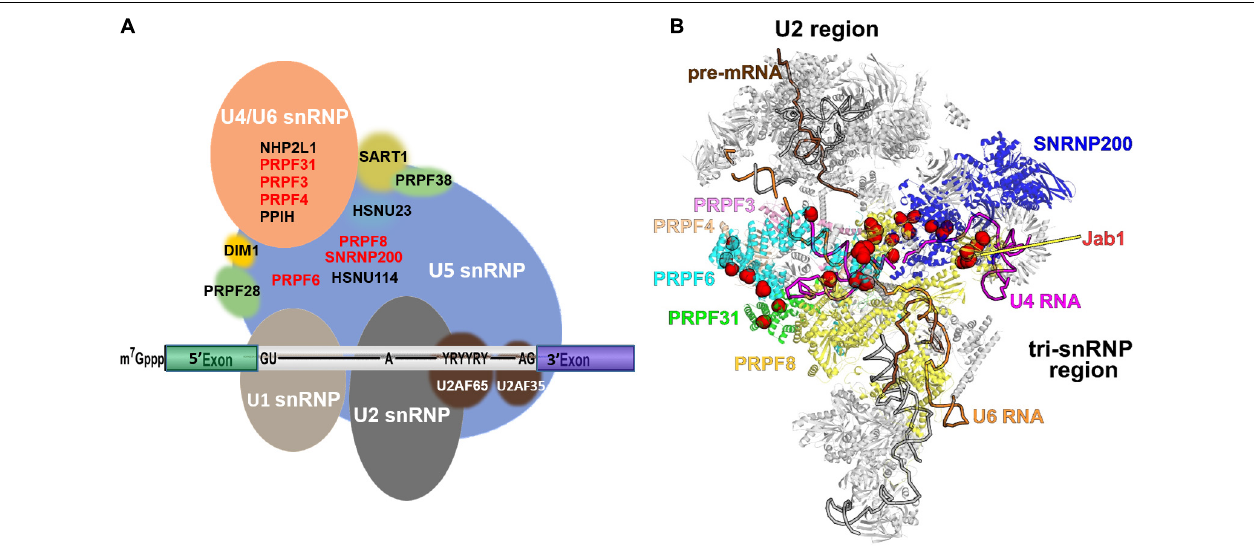
FIGURE 2 | Schematic diagram illustrating the structures of spliceosome complex B and tri-snRNP. (A) Composition of complex B; (B) cryo-EM structure of pre-catalytic spliceosome complex B with RP-linked PRPFs highlighted. The pre-mRNA, U4, and U6 snRNAs are colored brown, magenta, and orange, respectively. Six PRPFs, which are core components of tri-snRNP, are labelled and color-coded. Residues mutated in RP are shown as red spheres. The PRPF8 Jab1 domain is labelled. The image was created using PyMol (DeLano, 2002).